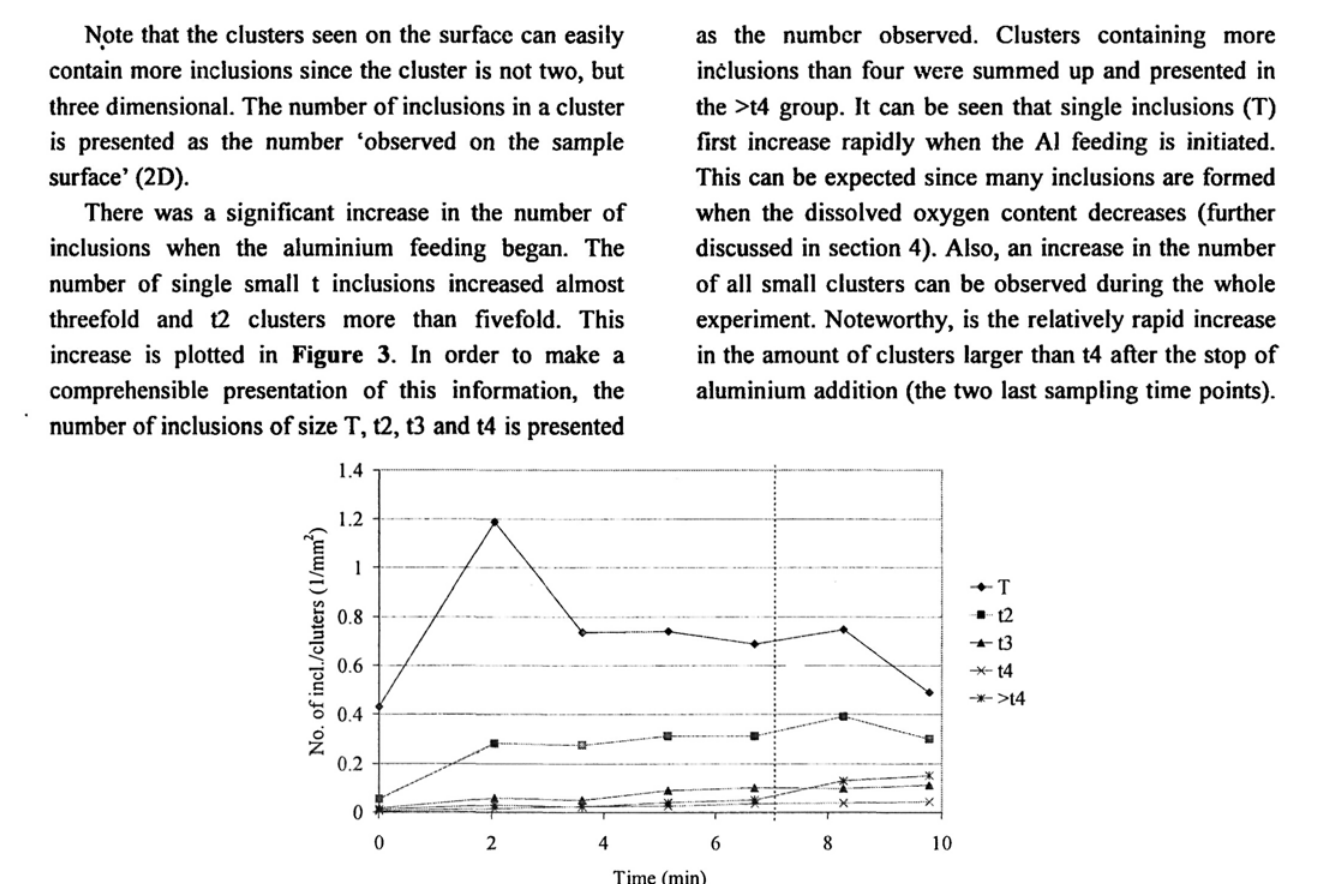
Fig. 3: No. of single small inclusions (T) and small clusters as function of time. Numbers determined with microscope. Dotted vertical line indicates end of aluminium addition (start at time zero)